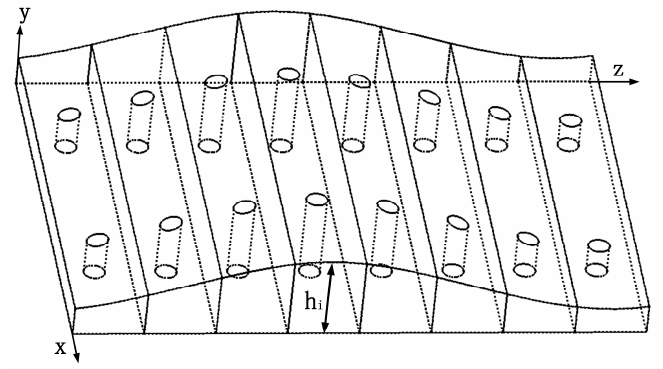
Figure 2. Sketch of gas film in the circumferential direction.